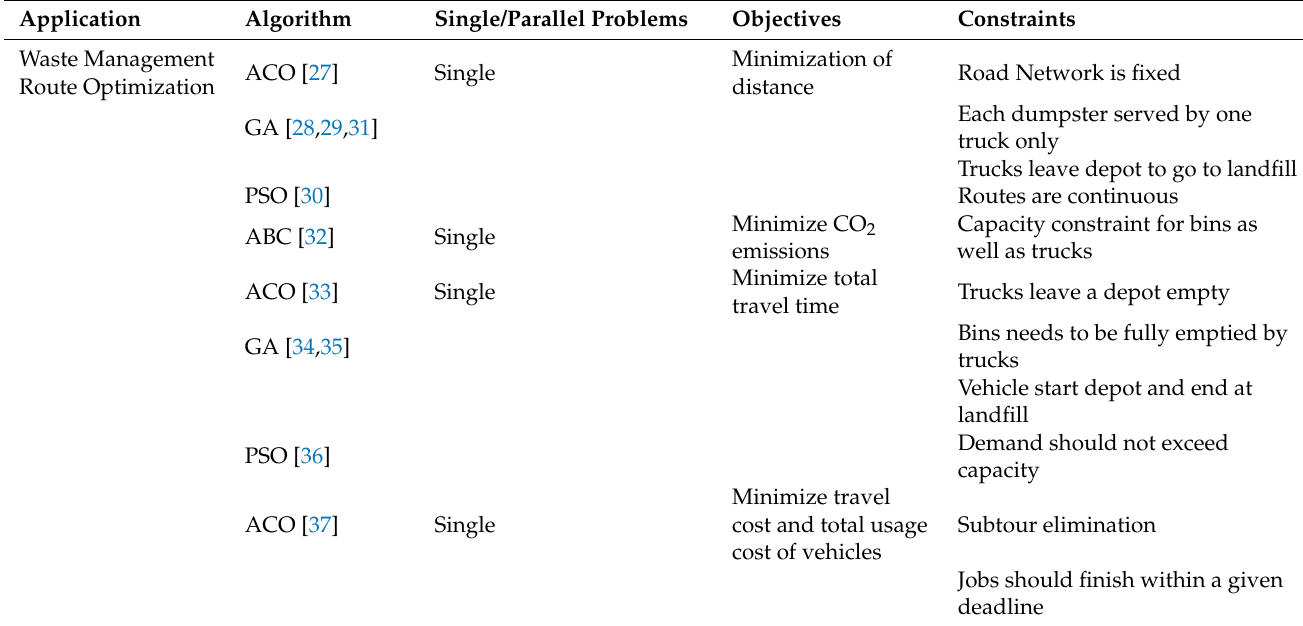
Table 3. Optimization in Smart City Services.